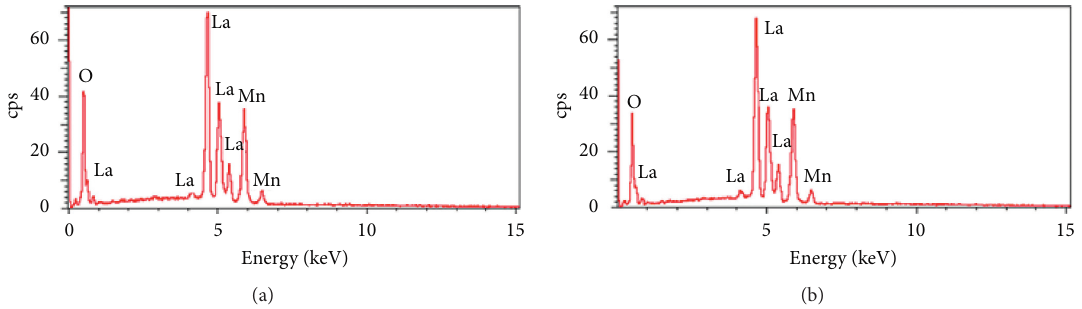
Figure 3: EDS spectra of the LaMnO